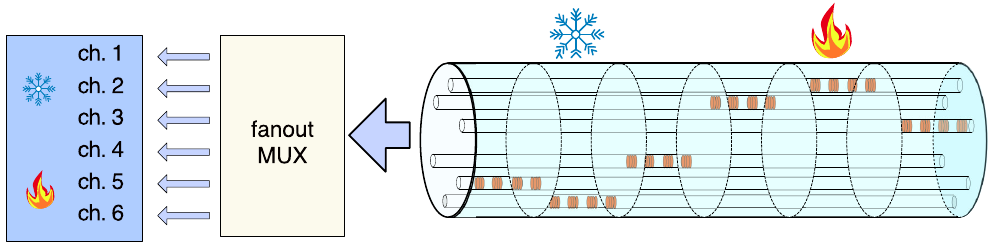
Figure 2. Optical fiber sensing networks with extended length based on a multicore fiber with selectively inscribed FBGs in the cores. In case of temperature measurements performed in both cases, the local temperature changes are detected in discriminated